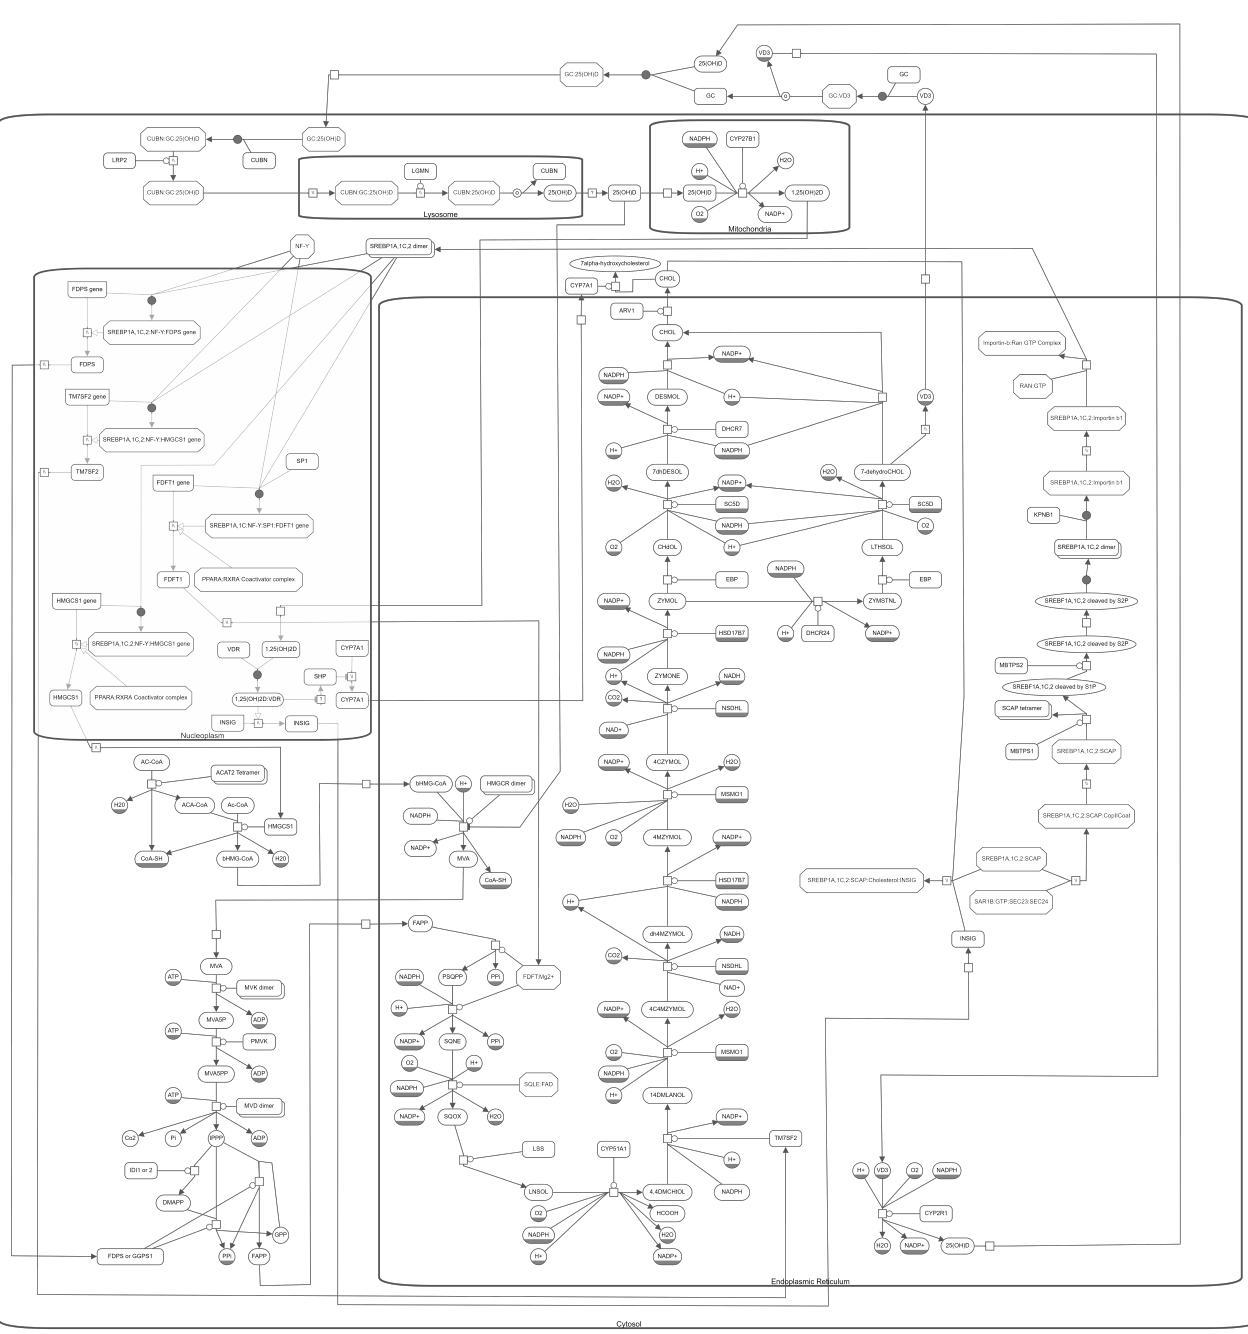
Figure 2. The cholesterol and vitamin D biosynthesis pathways as described in the Reactome database [187], along with the three mechanisms of feedback from the vitamin D pathway that regulate the pathways. The pathways are shown using the Systems Biology Graphical Notation [185] and this map is available for download from the Supplementary Materials in the semantically meaningful, machine readable Systems Biology Graphical Notation Markup Language format